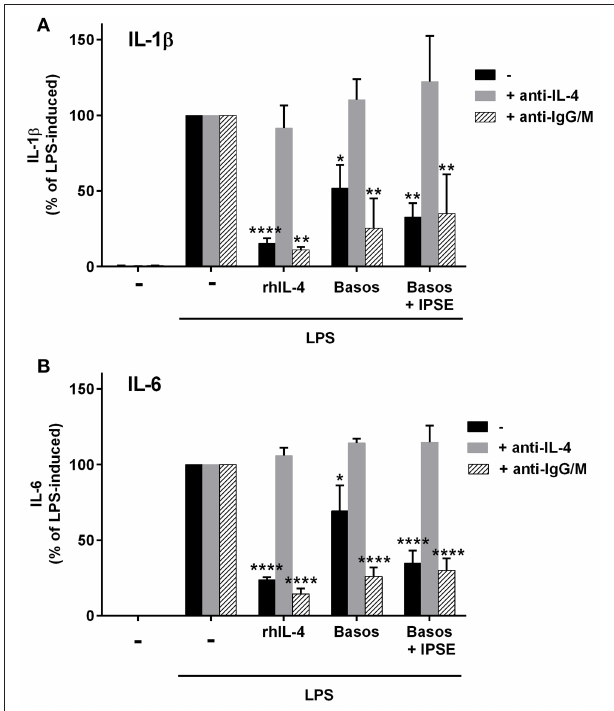
FIGURE 3 | Anti-IL-4 abrogated the inhibitory effect of IPSE/alpha-1-triggered basophil-derived IL-4. Release of IL-1 β (A) and IL-6 (B) from monocytes co-cultured with autologous basophils without (black bars) or with anti-IL-4 antibodies (gray bars) or with anti-IgG/M (bars with pattern) as control antibody. Inhibition of both IL-1 β and IL-6 from LPS-activated monocytes was abrogated by anti-IL-4, while anti-IgG/M had no effect on the inhibition. Data were normalized to the maximum release following LPS activation (100%). Data are presented as mean ± SEM, n = 4 for anti-IL-4 and n = 2 for anti-IgG/M. Statistics were performed by two way ANOVA multiple comparison test; * = significance “LPS + additions (IL-4, basophils, basophils + IPSE)” vs. “LPS alone”; * p < 0.05, ** p < 0.01, **** p <